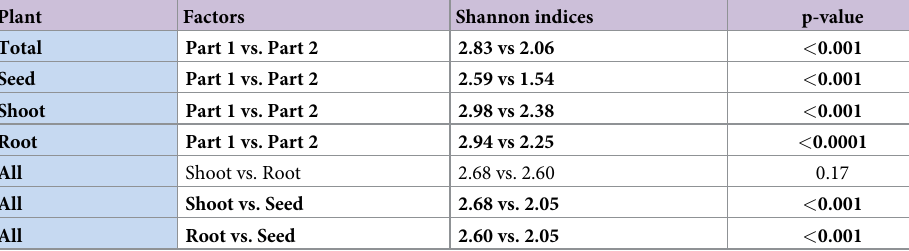
The comparison was analyzed between two locations (Part 1 or Part 2) and among different plant tissues of switchgrass plants from the coal-mining site with the p-values being calculated by Hutcheson t-test.